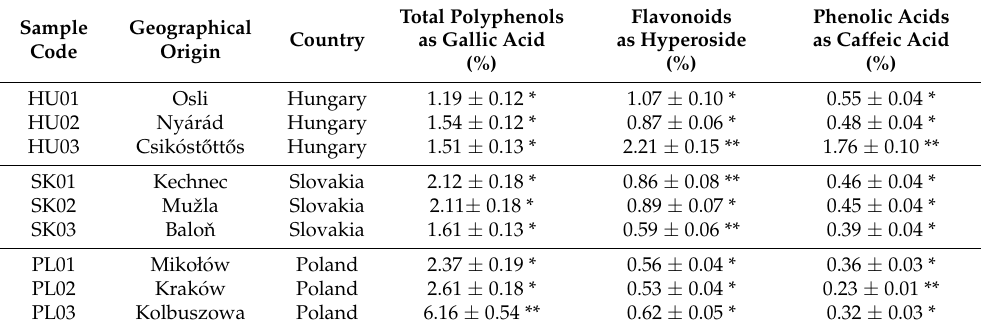
Table 4. Content of total polyphenols, flavonoids, and phenolic acids of Hungarian-, Slovak-, and Polish-origin goldenrod honey.